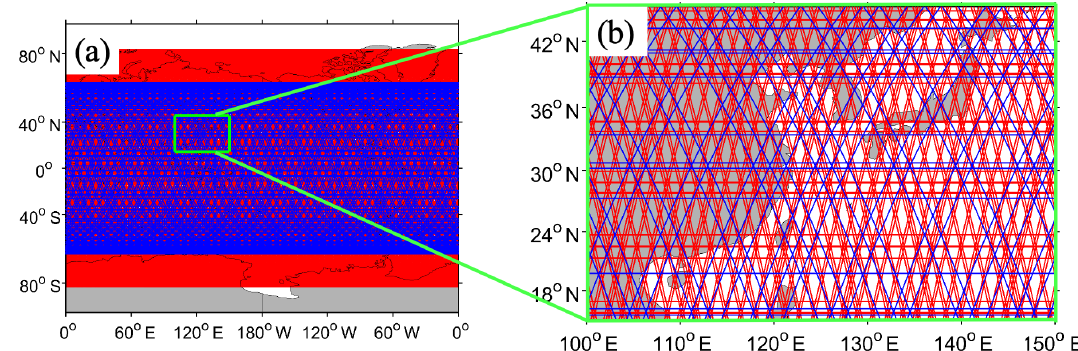
Figure 1. The ground projection tracks of satellite Jason-2 (blue line, with an inclination of 66 ◦ N(S)) and SARAL (red line, with an inclination of 88 ◦ N(S)) in one cycle over approximately 10d and 35d, respectively, in the (a) global and (b) East Asia domains (zoomed out of green box in a